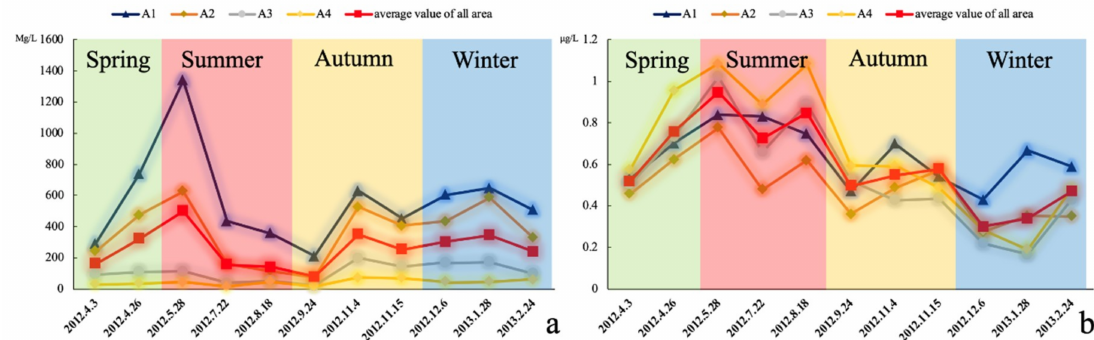
Figure 6. The average values of TSS ( a ) and Chla ( b ) in all study areas and four regions from every model calculation based on 11 MODIS data in the time period of abnormal fluctuations of wind speed (WS) and precipitation